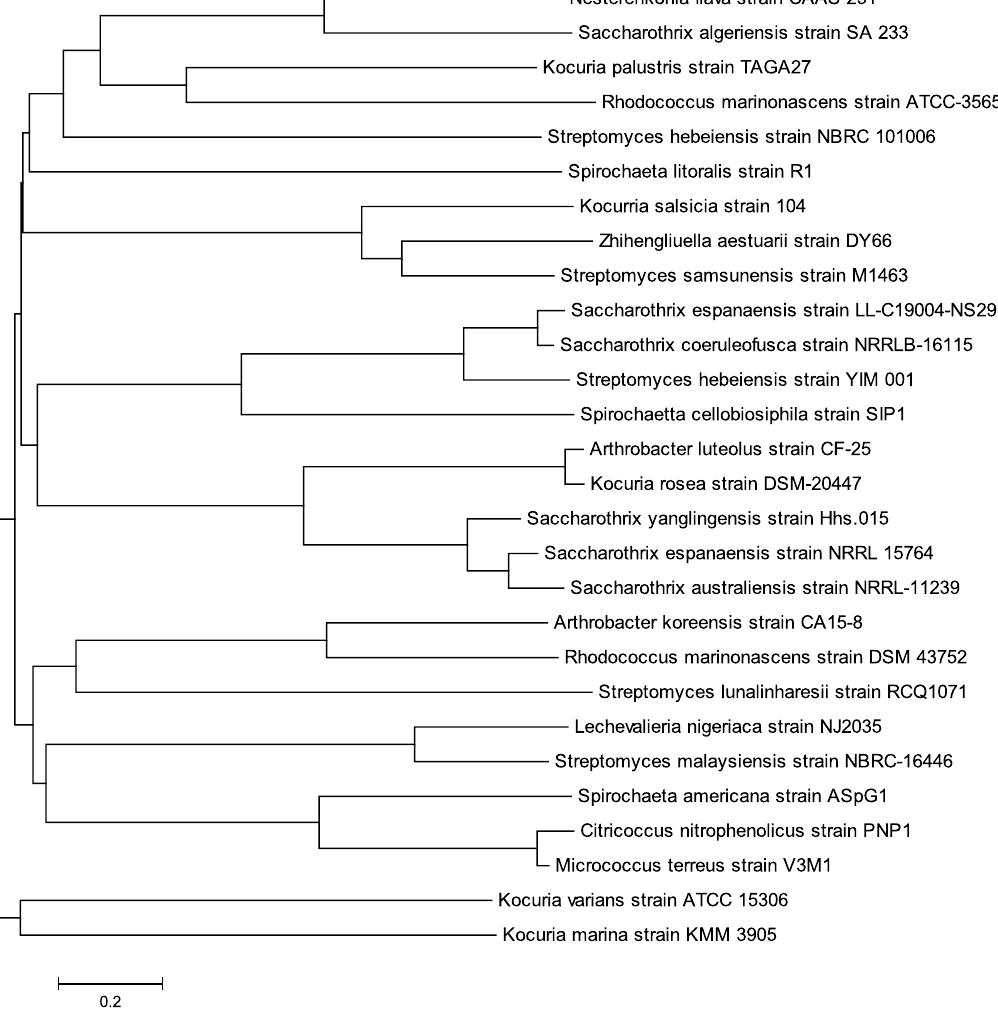
Fig. 3. Phylogenetic tree based on 16S rRNA gene sequences, showing bacterial populations present in Perna perna. The tree was generated using the Neighbour-Joining method. The numbers at the nodes indicated the bootstrap valves (1,000 replications). The bar 0.2 indicates the nucleotide substitution per position.